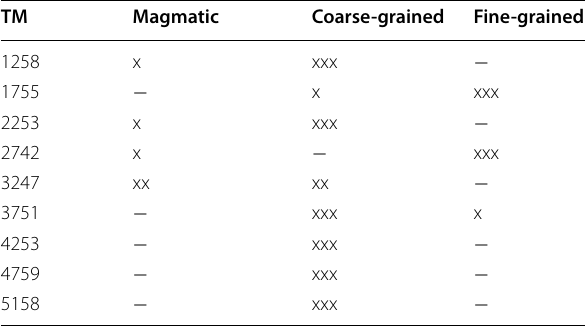
Table 3 Estimation of abundance of magmatic quartz, recrystallized